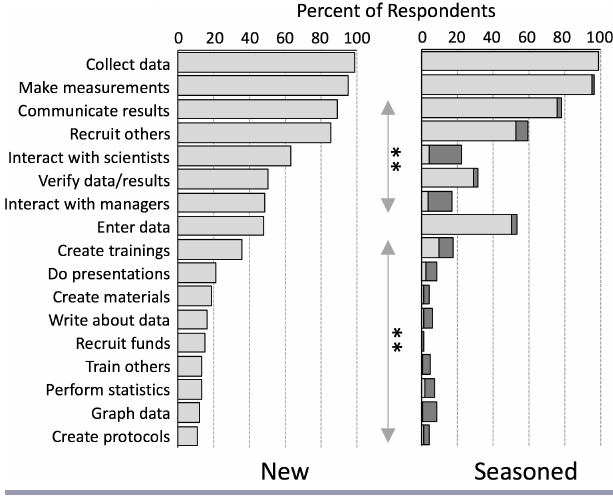
Fig. 5 . Distribution of tasks within the Coastal Observation and Seabird Survey Team program as a function of engagement: new participants (light gray indicates “will do”); seasoned participants (light gray indicates “currently perform”; dark gray indicates “want to do”). Asterisks indicate significant differences (p < 0.01) for chi-square contingency table tests comparing new and seasoned participants, i.e., new (will do) versus seasoned (currently perform). See Appendix 3 for statistical values and additional